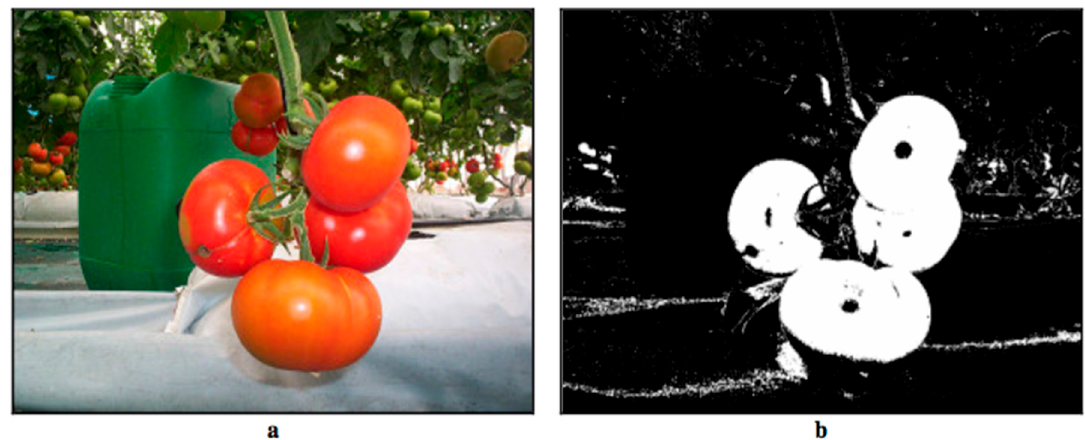
Figure 9. ( a ) Original image; and ( b ) segmentation based on color 1 (the whole ripe surface is